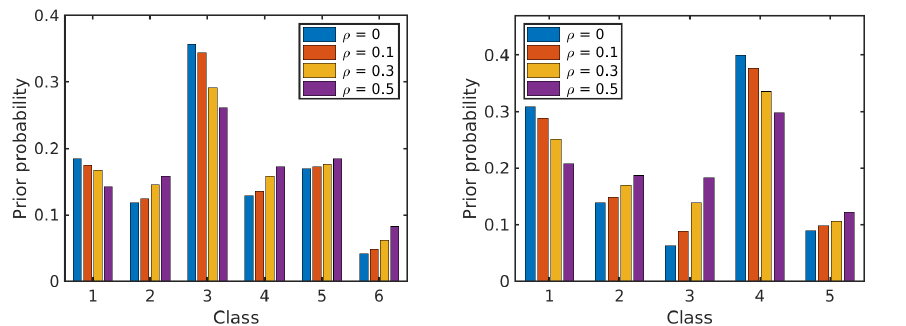
Figure 7. The effect of erroneous labels on prior probabilities of classes in the two data sets: Salinas Scene ( left ) and HYDICE Urban ( right ).